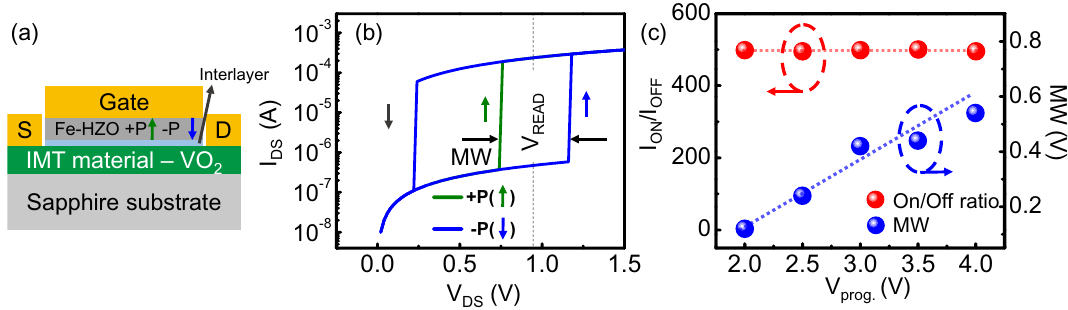
Figure 2. Mott-FeFET operation. ( a ) Schematic of the proposed Mott-FeFET. ( b ) I ds versus V ds characteristics of the VO 2 channel as a function of the ferroelectric polarization. ( c ) Observed ratio between read currents corresponding to state 1 and 0, as a function of the applied program voltage. It can be observed that I ON /I OFF ratio, unlike in a conventional FeFET remains